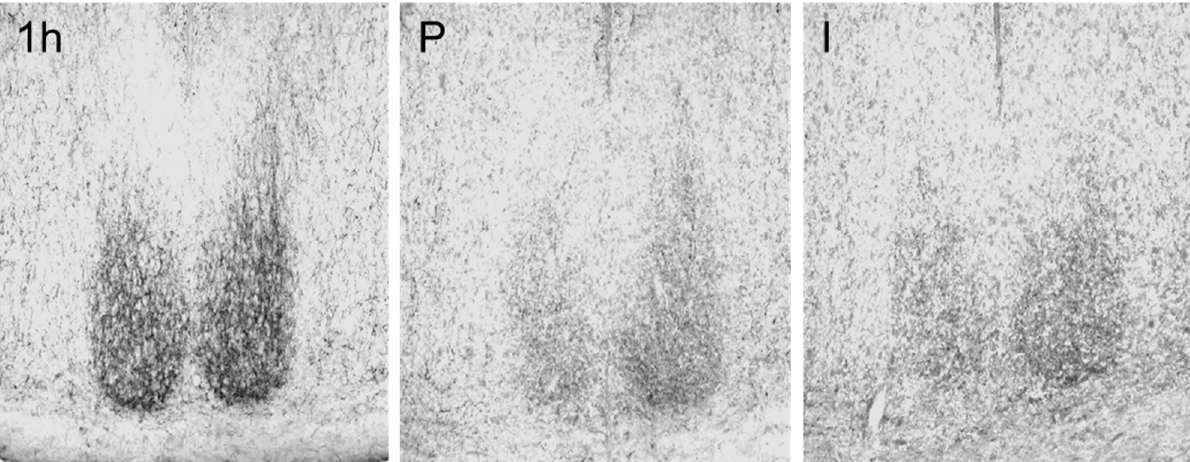
Figure A7. Neuropeptide Y immunoreactivity in the suprachiasmatic nucleus of Syrian hamsters. Comparison between 1 h manual sleep deprivation (1 h, group 3a), sexual stimulation with pheromone (P, group 2), and immobilization stress (I, group 4). Magnification: 40×.